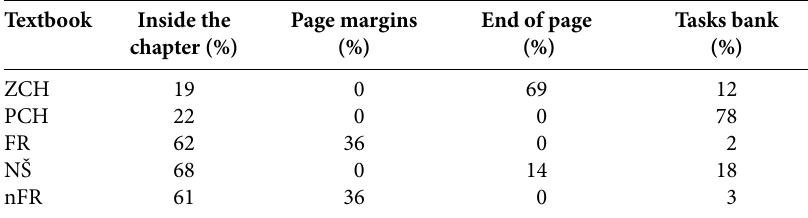
Table 4: Task location in the textbooks Textbook Inside the